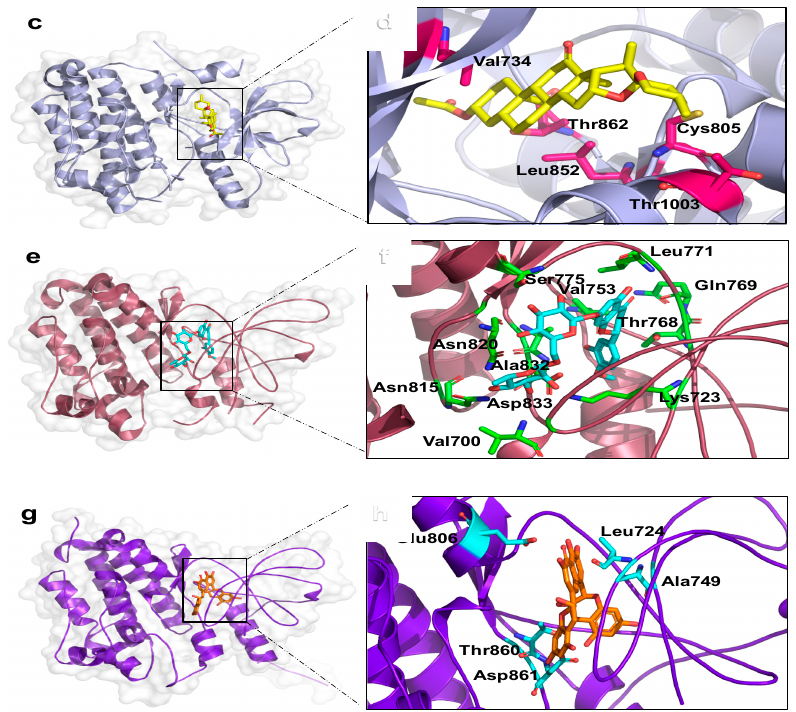
Figure 4. 3D Structures for HER-NP complexes (left) and interacting residues on binding site (right). HER1 (2ITW)-podototarin ( a , b ); HER2 (3PP0)-hecogenin acetate ( c , d ); HER3 (3LMG)-hesperidin ( e , f ); HER4 (2R4B)-theaflavin ( g , h ).